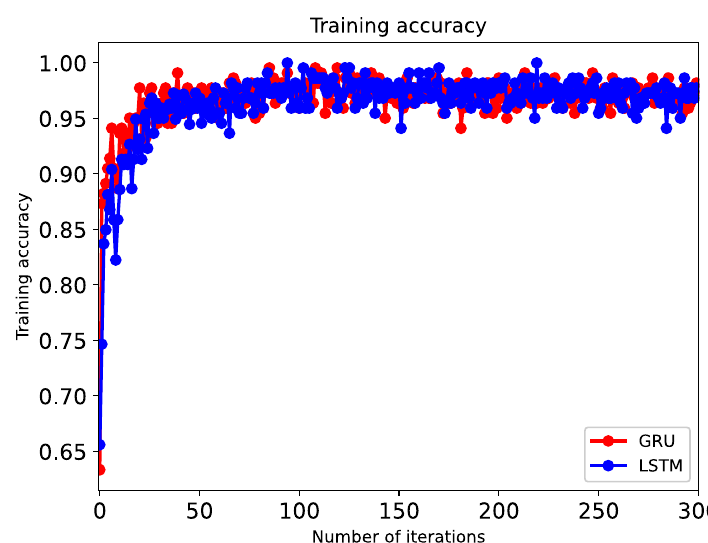
Figure 15. Plot of comparison of iterative convergence of two models.